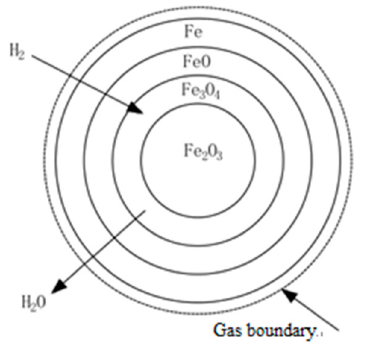
Figure 5. Unreacted shrinking core model.